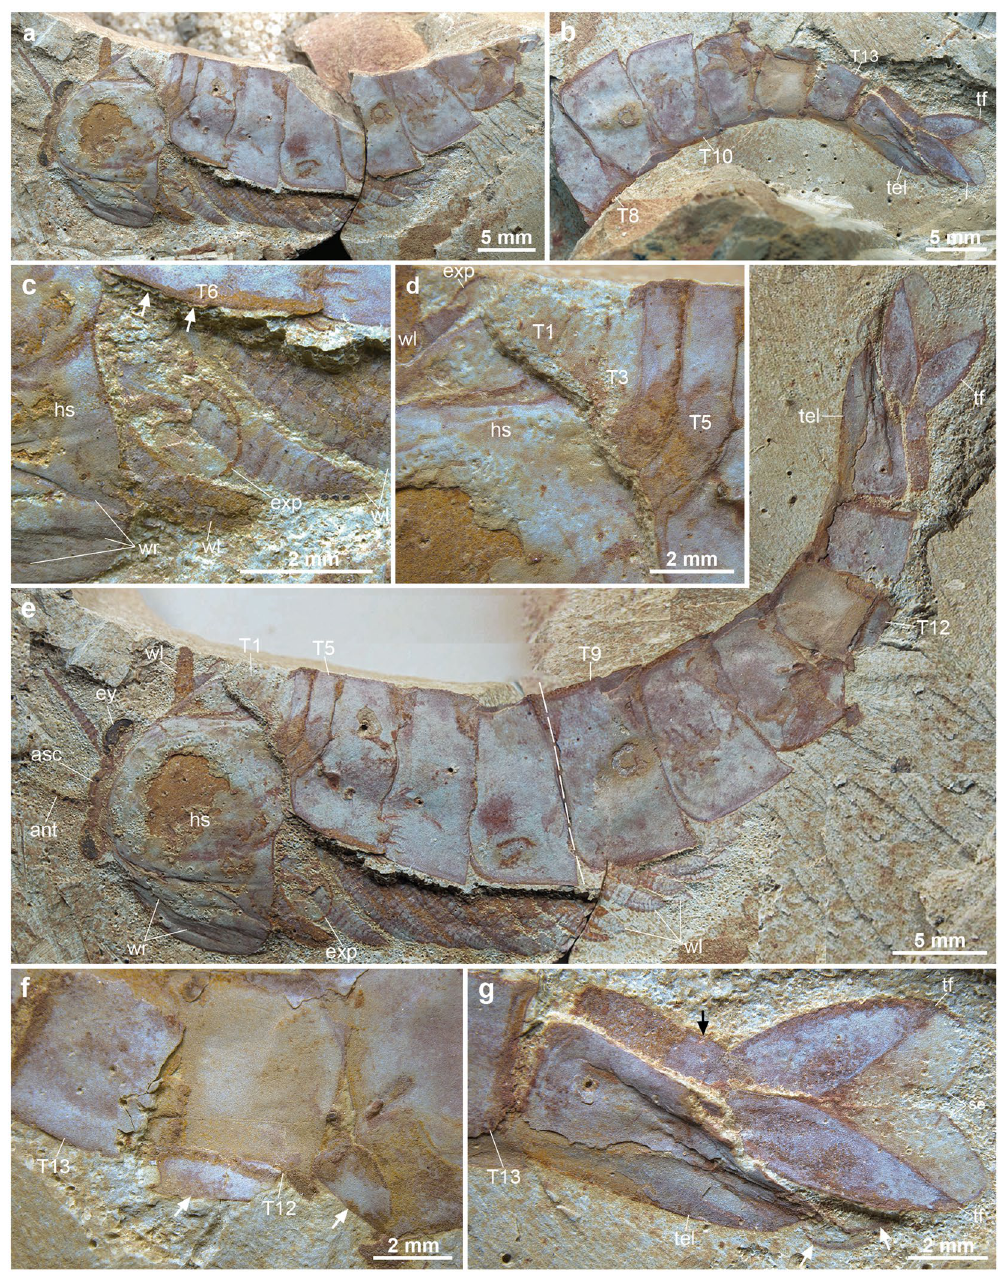
Figure 1. Alacaris mirabilis from the Cambrian (Stage 3) Xiaoshiba Lagerstätte in Kunming, southern China. ( a ) YKLP 12270a, dorsal view of the head shield and anterior portion of trunk. ( b ) YKLP 12270b (counterpart), showing the posterior portion of trunk and telson. ( c ) Close-up showing the layer of sediment (arrowed) separating the well sclerotized trunk tergites from the wrinkled head shield. ( d ) Close-up of the five reduced anterior tergites articulated to the remainder of the trunk, and overlapping the carcass head shield. ( e ) Restored specimen by digitally combining YKLP 12270a and 12270b by computer amalgamation (using photomerge software), the dashed line indicates the contact of YKLP 12270a by 12270b. ( f ) Close-up view of 11 th to 13 th tergites with fragments of duplicated tergites (arrows). ( g ) Close-up of the moulted telson articulated with the complete trunk tergite series and displaying paired tail flukes (white arrows), overlapping the pristine underlying telson (black arrow) with complete flukes and posteriorly-pointing setae. Abbreviations: ant, antenna; asc, anterior sclerite; exp, exopod; ey, eye; hs, head shield; tel, telson; tf, tail fluke, T n , trunk tergites; wl, walking leg; wr,